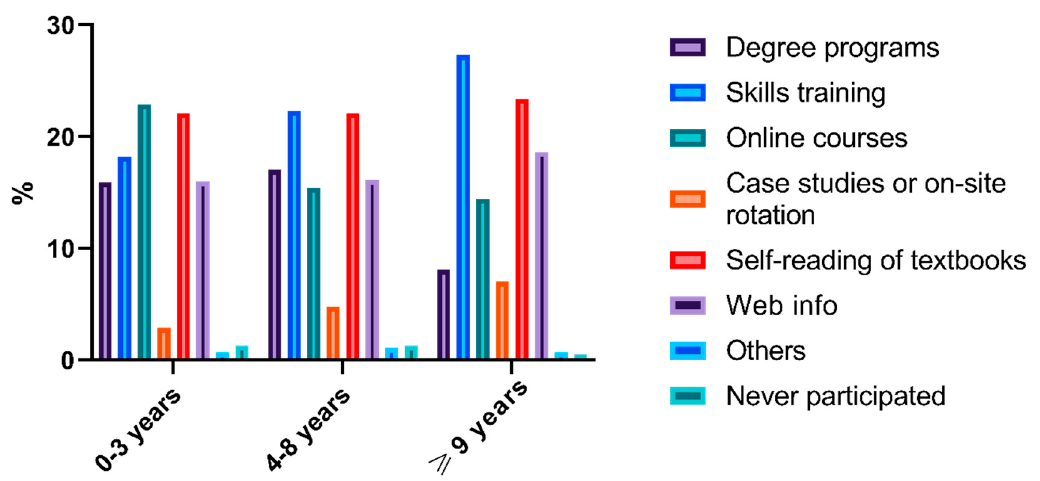
Figure 3. Histogram of capacity enhancement activities based on seniority.